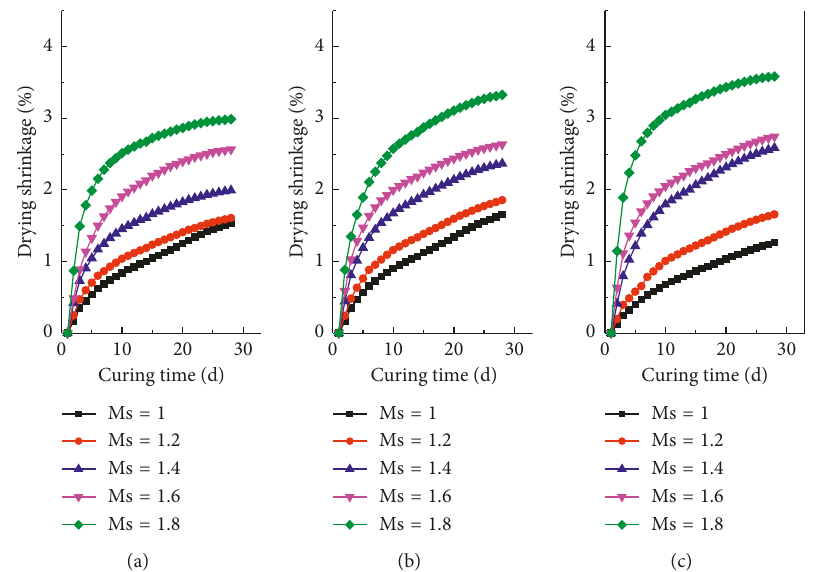
Figure 4: The effects of the silicate moduli and Na 2 O contents on drying shrinkage of AAS pastes. (a) 6% Na 2 O. (b) 8% Na 2 O. (c) 10% Na 2